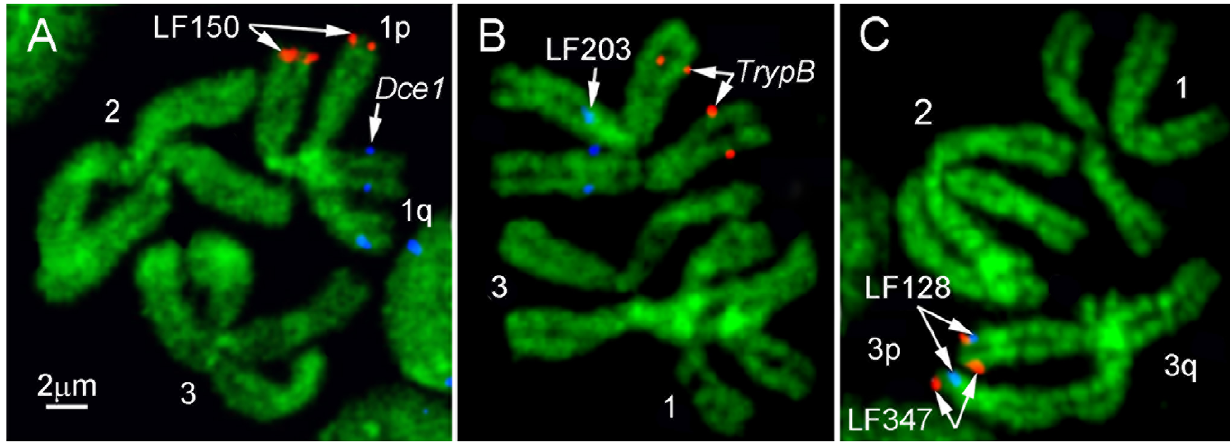
Figure 2. FISH on early metaphase chromosomes of Aedesaegypti . BAC DNA probes labeled by CY3 (red) and Cy5 (blue) were hybridized to the chromosomes stained with YOYO-1 iodide. Positions of the BAC clones on chromosomes 1 (A), 2 (B), and 3 (C) are indicated by